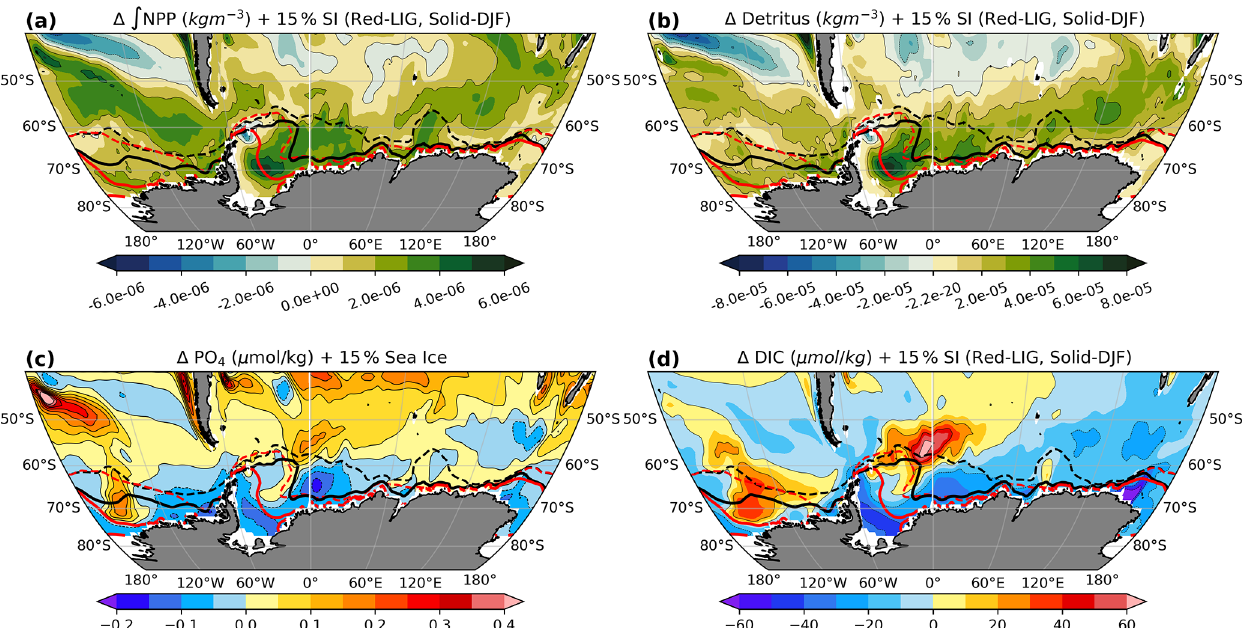
Figure A4. Changes in annual mean productivity and related variables. (a) Anomalies of depth-integrated annual mean NPP (as chlorophyll in seawater, kgm − 3 ) overlaid with 15% sea ice concentration (black for PI, red for LIG, solid lines for DJF, and dashed lines for JJA). (b) Anomalies of annual mean detrital concentration at 200m depth (kgm − 3 ) overlaid with sea ice (same as a ). (c) Anomalies of annual mean surface phosphate concentrations (µmolkg − 1 ) overlaid with sea ice (same as a ). (d) Anomalies of annual mean surface DIC concentrations (µmolkg − 1 ) overlaid with sea ice (same as a